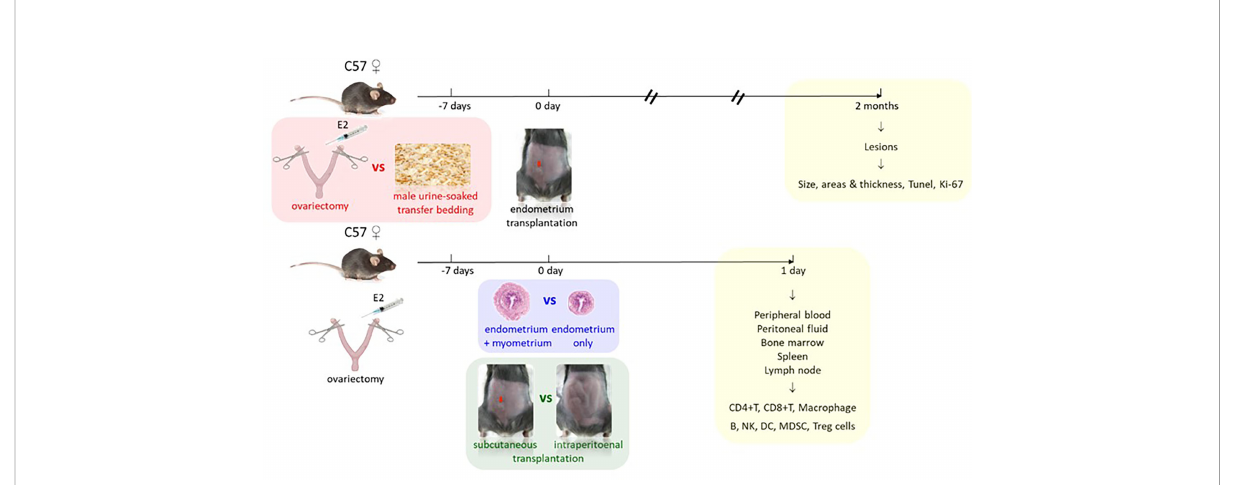
FIGURE 1 Study design. Comparison 1 (red): estrus synchronization by ovariectomy with estrogen supplement (E2) versus male urine-soaked transfer bedding with endpoint 2 months after transplantation for pathological studies (yellow). Comparison 2 (blue): endometrium preparations by whole uterus including endometrium and myometrium versus solely endometrium. Comparison 3 (green): surgical transplantation by subcutaneous (red arrow) versus intraperitoneal transplantation with endpoint 1 day after transplantation for immunological studies